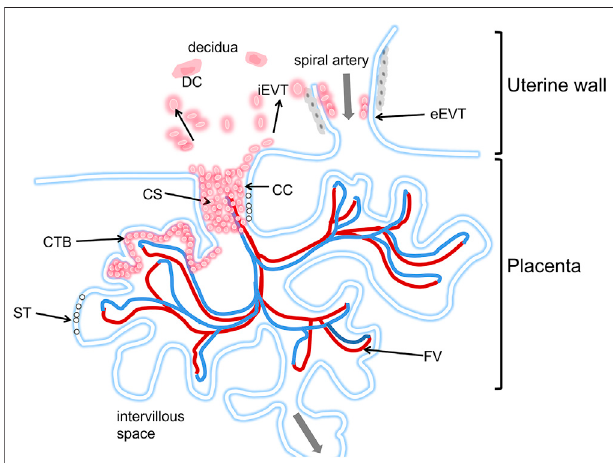
FIGURE3| Schematicdiagramofthehumanplacentalimplantationsite. The placenta isin the lower part of the picture, Located in the villi spaceabove theuterine wall, andadjacenttoauterinespiralartery.Thematernalblood fi rst immersedintheSTlayer,anddirectlybelowtheSTlayeristheCTBlayer. The blood fl owstothefetus through theumbilicalcord (seegray arrow). iEVTs are depicted breaking through the CS and invading through the decidua. iEVTs, Invasive interstitial extravillous cytotrophoblasts; ST, Syncytiotrophoblast; CTB, cytotrophoblast; CC, cell column; CS, cytotrophoblast shell; DC, decidual cell; FV, fetal